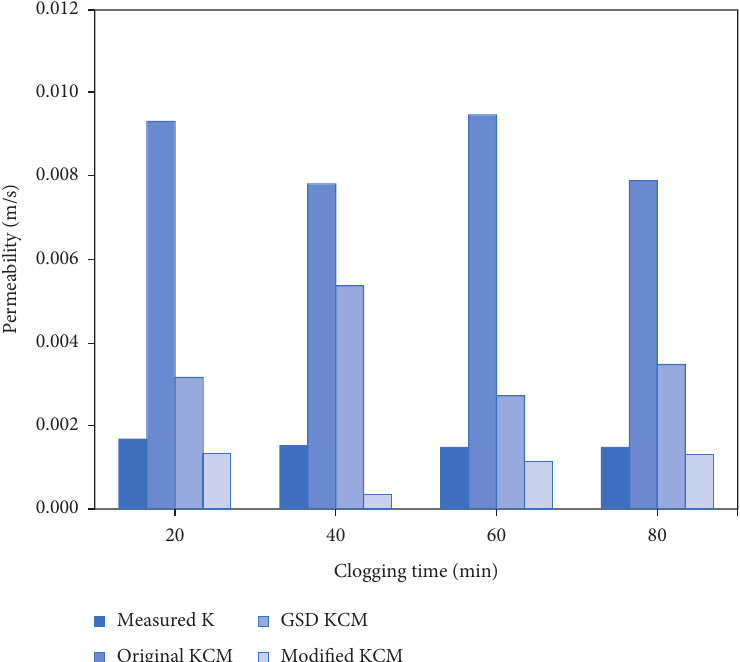
Figure 9: Comparison of measured permeability and estimated permeability with KCM models for PUPM 8-H during the clogging periods of 20, 40, 60, and 80 minutes. Table 2: Constant parameters of the modified KCM models in terms of the clogging for PUPM 8-H. Specimens